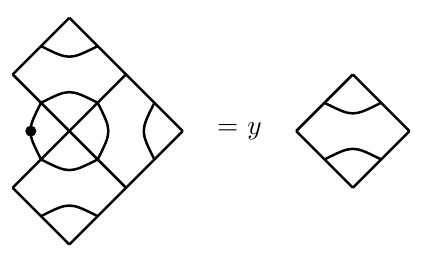
Figure 5 . Graphical interpretation of the blob algebra relation e 1 be 1 = ye 1